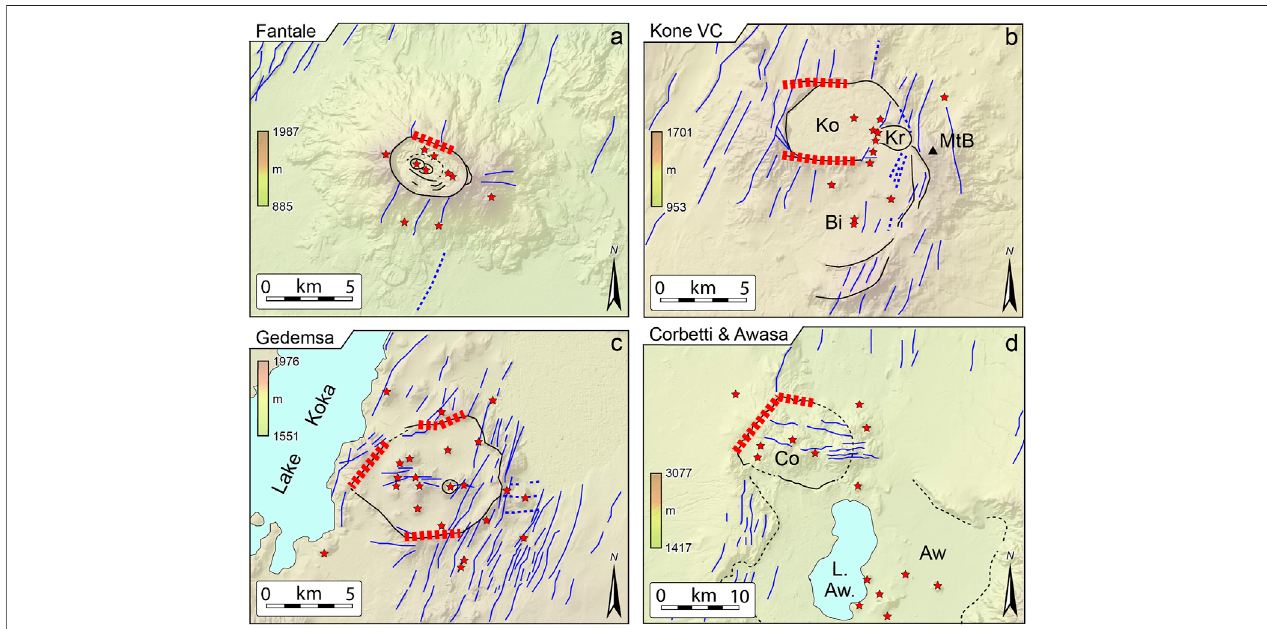
FIGURE 11 | Structural control on collapsed caldera margin at (A) Fantale, (B) Kone Volcanic complex (KVC), (C) Gedemsa and (D) Corbetti. Red dashed lines indicate caldera ring faults controlled by inherited structures reactivated during the collapse. Red stars mark volcanic emission points (modi fi ed from Maestrelli et al., 2021). Ko: Kone caldera; Kr: Korke caldera; Bi: Birenti caldera; MtB: Mount Birenti; Co.: Corbetti; L. Aw, Lake Awasa; Aw: Awasa caldera remnants.